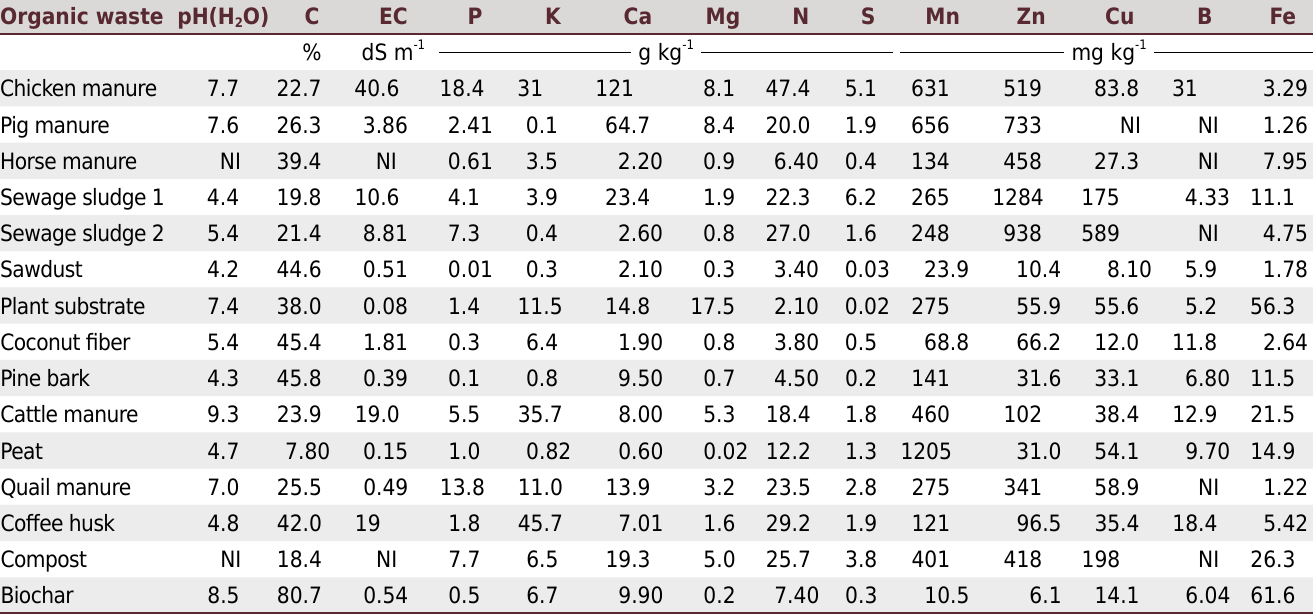
Table 2. Macro and micronutrient contents (dry basis), pH in water, carbon (C), and electrical conductivity (EC) of the studied organic wastes Organic waste pH(H 2 O) Chicken manure Pig manure Horse manure Sewage sludge 1 Sewage sludge 2